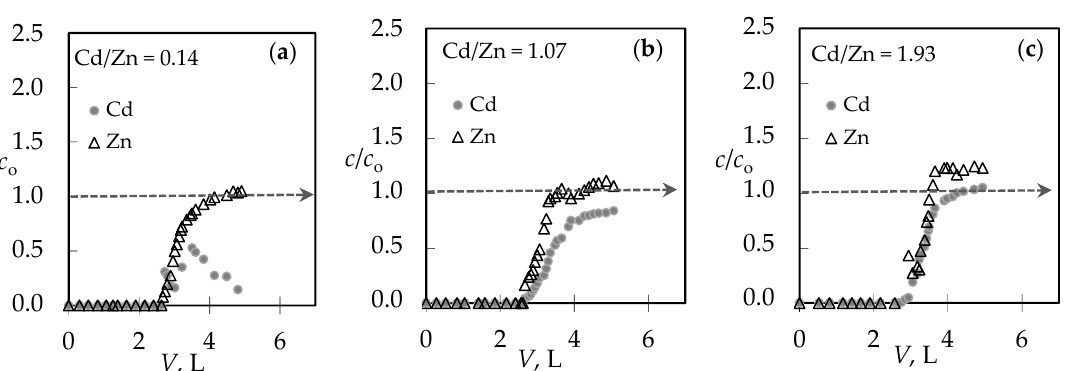
Figure 3. The breakthrough curves for each metal ion in the binary (Pb + Zn) solution for different Pb/Zn ratios: ( a ) Pb/Zn = 0.19; ( b ) Pb/Zn = 1.07 [43]; and ( c ) Pb/Zn = 2.15. Note: c / c o = c (Pb)/ c o (Pb) or c (Zn)/ c o (Zn).